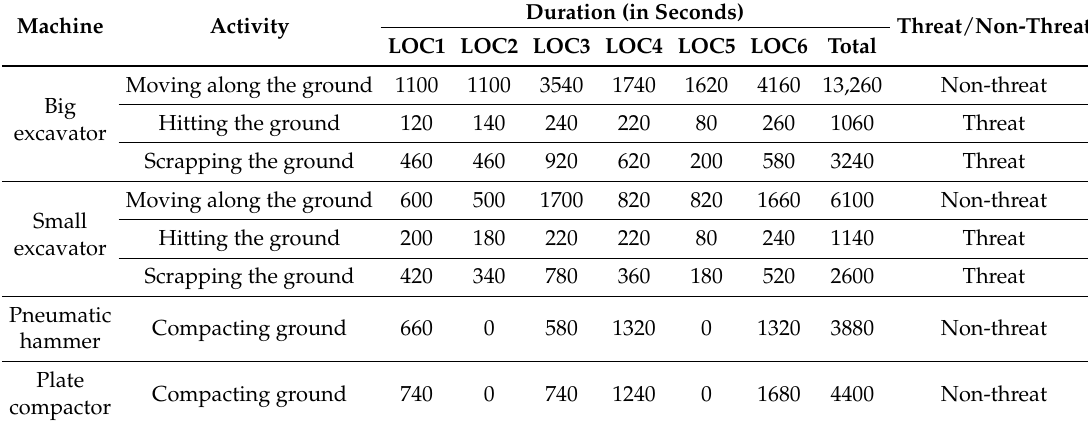
Table 1. Experimental database. ”Big excavator” is a 5-ton Kubota KX161-3. ”Small excavator”